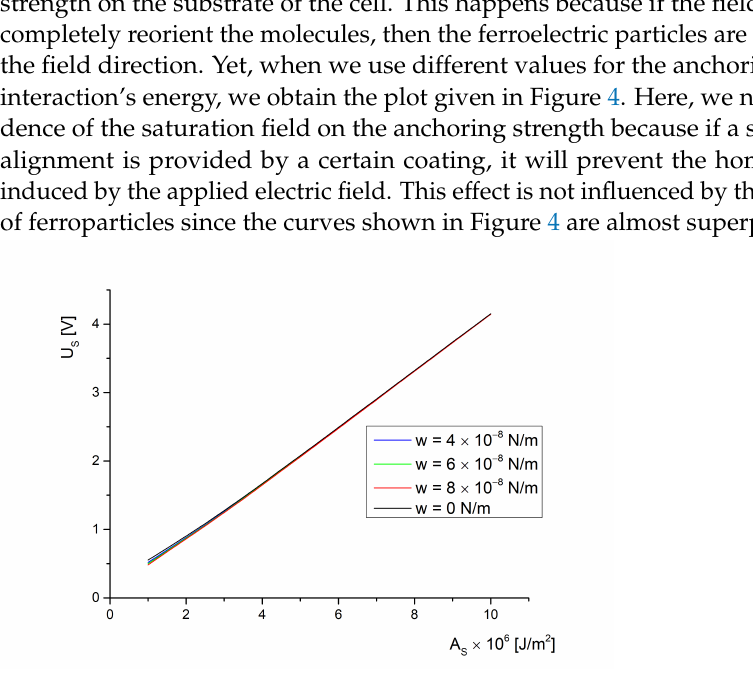
Figure 4. Saturation voltage versus anchoring energy of molecules on the